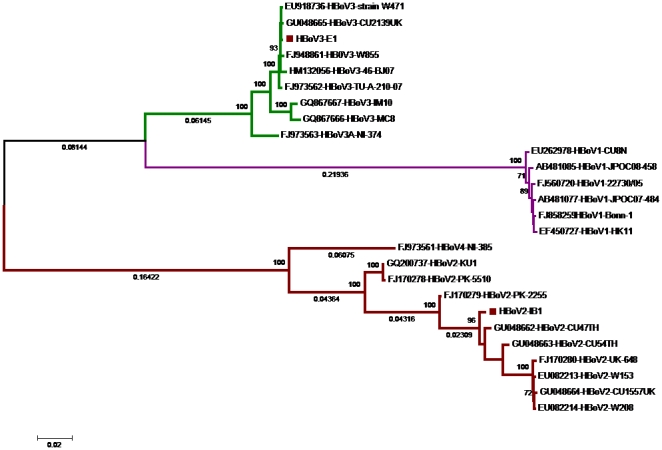
Comparative phylogenetic analysis of HBoV3-E1 and HBoV2-IB1 (filled rectangles).Nucleotide alignments were generated using the complete coding sequence of the NS, NP and VP genes. Names of sequences used for analysis are shown as Genbank accession numbers followed by the names of HBoV species and strains. The tree was constructed with the maximum likelihood method using a GTR+G substitution model [38]. Bootstrap replicates (>70%) are shown above the branches and distances (>0.02) are shown below the braches.